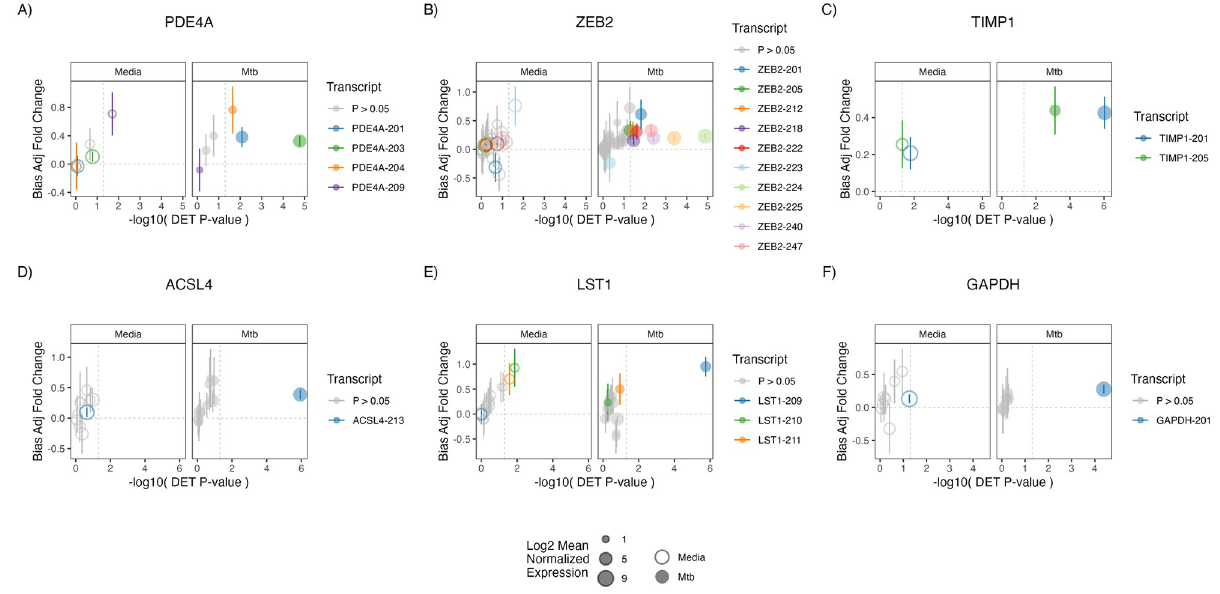
Fig 3. Transcript isoform specific relative expression reveals unique and conserved expression patterns across newly identified genes with RSTR- associated DETs. For the indicated genes with at least one DET of interest, each transcript isoform is plotted as a node according to RSTR—LTBI fold- change with standard error and P value. Significant DETs (P < 0.05, vertical dashed line) are indicated by paired colors to compare media (unfilled) and Mtb-stimulated (filled) conditions. Log2 mean normalized expression is indicated by size of transcript isoform node.